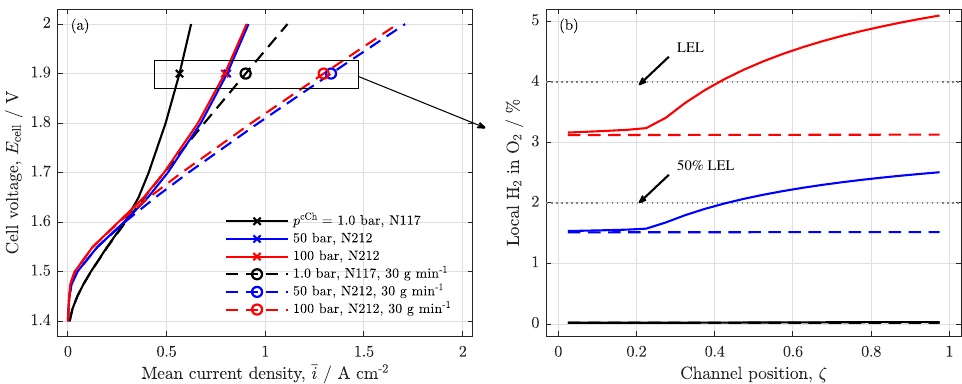
Figure 9. Safety and crossover analysis: ( a ) polarization curves at ambient ( p cCh = 1.0bar) and at increased cathode pressures (50bar and 100bar) with different membrane thicknesses (N117: δ m = 180µm, N212: δ m = 50.8µm) for water feeds of 30gmin − 1 (dashed lines with circles) and low water feeds of 0.4gmin − 1 (full lines with crosses); T = 60°C. ( b ) Local volume ratio of H 2 in O 2 along the anode channel for the different setups at a common cell voltage, E cell =